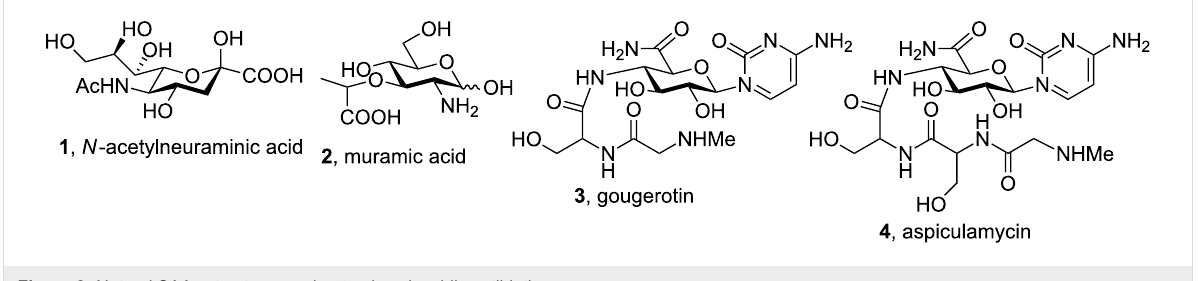
Figure 2: Natural SAAs structures and natural nucleosidic antibiotics.